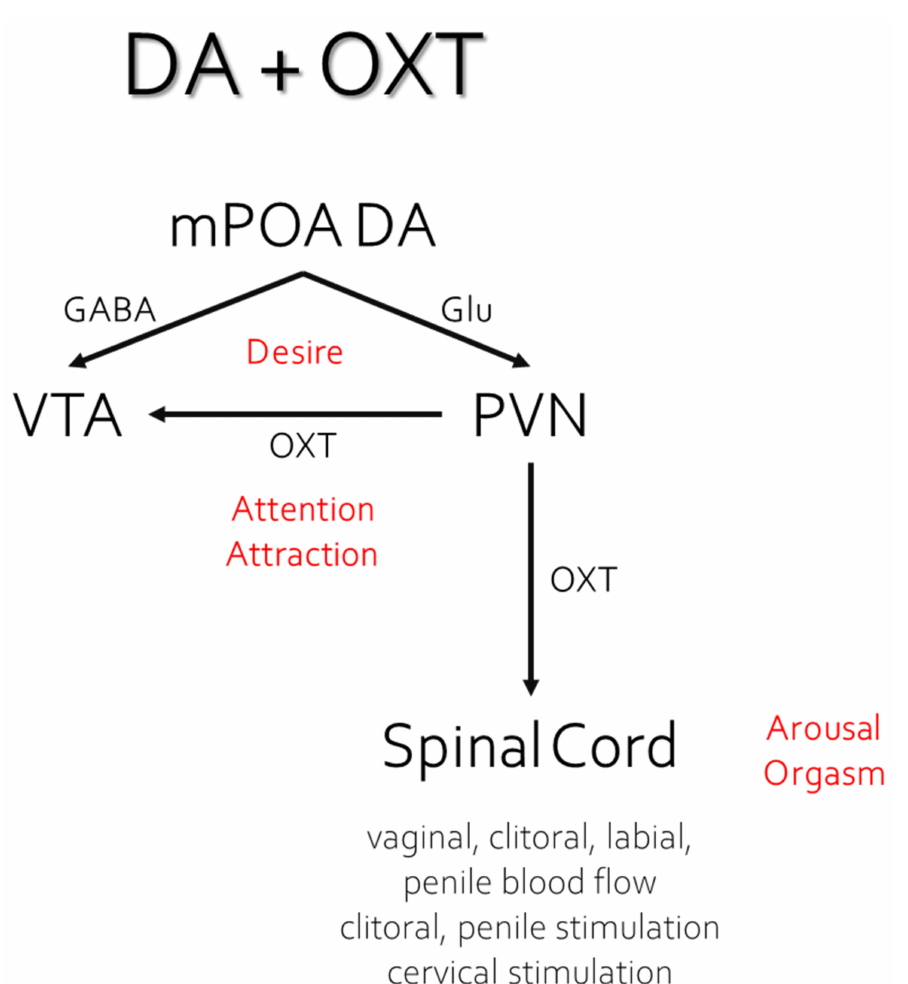
Figure 7. Coordination of genital blood flow, sexual desire, attraction, and orgasm by the interaction of DA and OXT in response to conditioned sensory cues; based on Melis and Argiolas [196]. Details are found in the